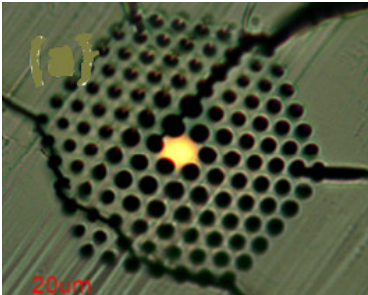
15 of 27 Figure 32. Cross-section of tested PCF and set up to measure current using electromagnetic vibration (Reproduced from [99], with the permission of author). A loss based ferrofluid (EMG905) infiltrated microstructured polymer optical fiber (MPOF) magnetic field sensor was demonstrated [100] which can measure the magnetic field change up to 2000 gauss for the magnetic field perpendicular to the fiber axis. The refractive index of the ferrofluid changes per magnetic field as ~1 × 10 −3 /100 G (Figure 33). A tapered PCF coated with ferrofluid (water- based ferrofluid EMG507, Ferrotec) was reported [101] as a magnetic field sensor. It was made by a tapered PCF spliced between two SMF. It has sensitivity 16.04 pm/G for the magnetic field range 100 to 600 G with resolution 0.62 G (Figure 34). Then a magnetic field sensing probe was proposed [34] which consists of a dual core PCF and both the cores are filled with Fe 3 O 4 magnetic fluid. These two cores behave as two separate wave guides and mode coupling takes place between them. Based on mode coupling different high magnetic field can be identified from spectral shift. This probe has sensitivity 305.8 pm/Oe (Figure 35). Very recently a SPR technique was combined with PCF for the purpose of magnetic field detection in which two parts of gold-layer-filled PCF are joined together to achieve a localized SPR effect [102]. Cladding air holes of the two PCF segments were filled selectively with magnetic fluid and force was applied on one of it (Figure 36). It gives some new way to think about SPR based magnetic field sensors. Recently Yin et al. demonstrated [103] a nanomagnetic fluid filled double clad PCF-based magnetometer which is working on a modal interference mechanism and has a sensitivity 114.5 pm/mT. Also a polarization maintaining PCF incorporated Sagnac interferometer was proposed [104] for magnetic field detection. Water based nanoparticles Fe 3 O 4 are